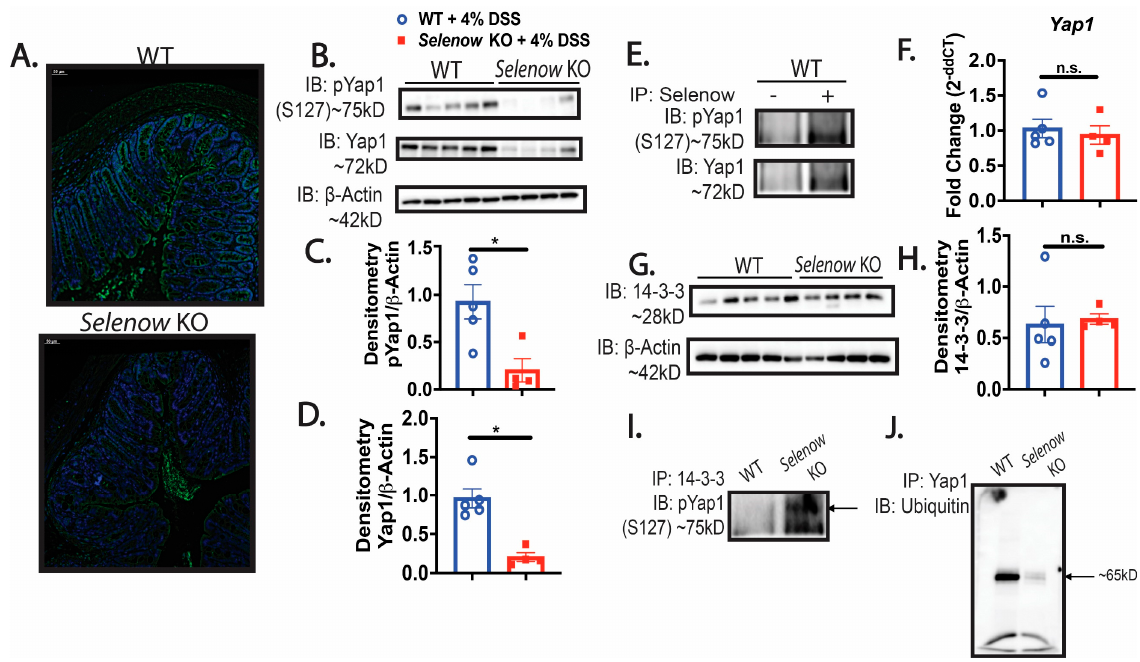
Figure 6. Decreased Yap1 expression in DSS-treated Selenow KO mice. ( A ) Representative immunofluorescence images of Yap1(green: AF488) co-stained with DAPI (blue) in WT and Selenow KO mice at day 8 post DSS (20× magnification; scale bar = 50 μ m). ( B ) Representative immunoblot of pYap1 (S127) and Yap1 and ( C , D ) quantification of pYap1 and Yap1 from colonic lysates of WT and Selenow KO mice at day 8 post DSS (WT = 5 mice; Selenow KO = 4). ( E ) Immunoprecipitation of Selenow with representative immunoblot of pYap1 and Yap1 from colonic lysates of control WT mice. ( F ) Yap1 mRNA expression in colon of WT and Selenow KO mice at day 8 post DSS (WT = 5 mice; Selenow KO = 4). ( G ) Representative immunoblot of 14-3-3 and ( H ) quantification of 14-3-3 from colonic lysates of WT and Selenow KO mice at day 8 post DSS (WT = 5 mice; Selenow KO = 4). ( I ) Immunoprecipitation of 14-3-3 with representative immunoblot of pYap1 (S127) from colonic lysates of WT and